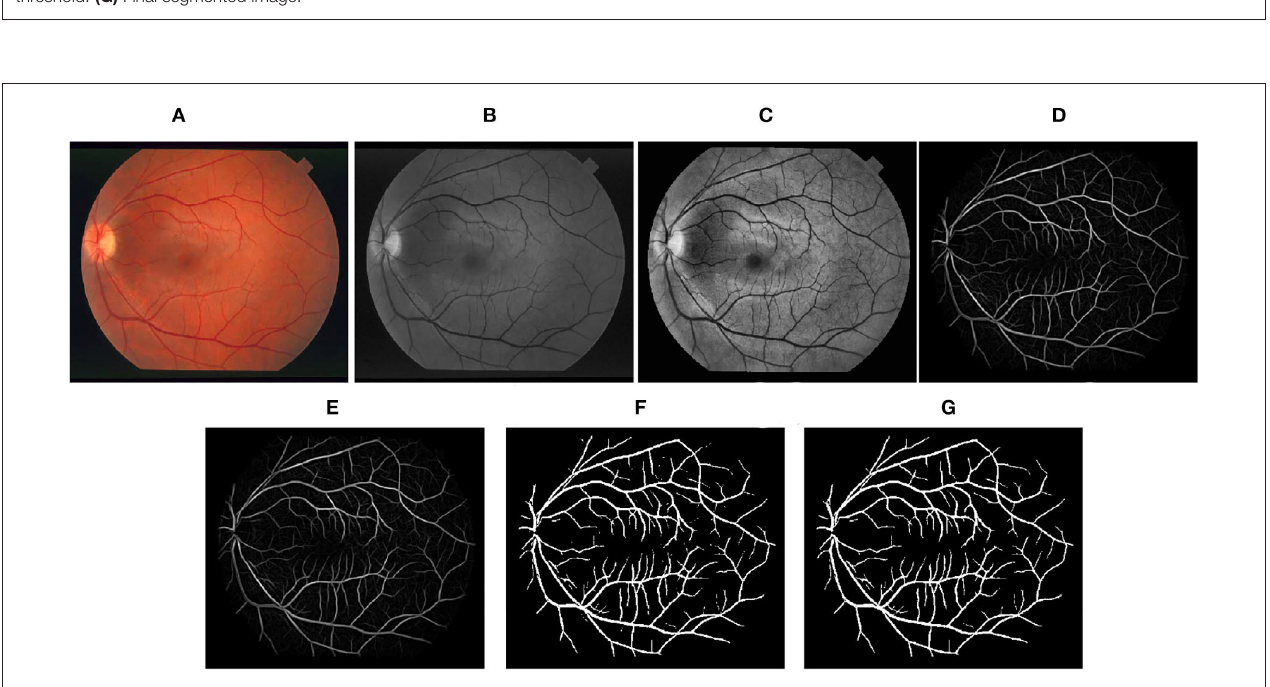
FIGURE 3 | Stepwise illustration of proposed method. (A) Color retinal fundus image from DRIVE database. (B) Green channel retinal fundus image. (C) Processing diagram after CLAHE. (D) Processing diagram after B-COSFIRE filters. (E) Processing diagram after morphological filters. (F) Processing diagram after binary threshold. (G) Final segmented image.